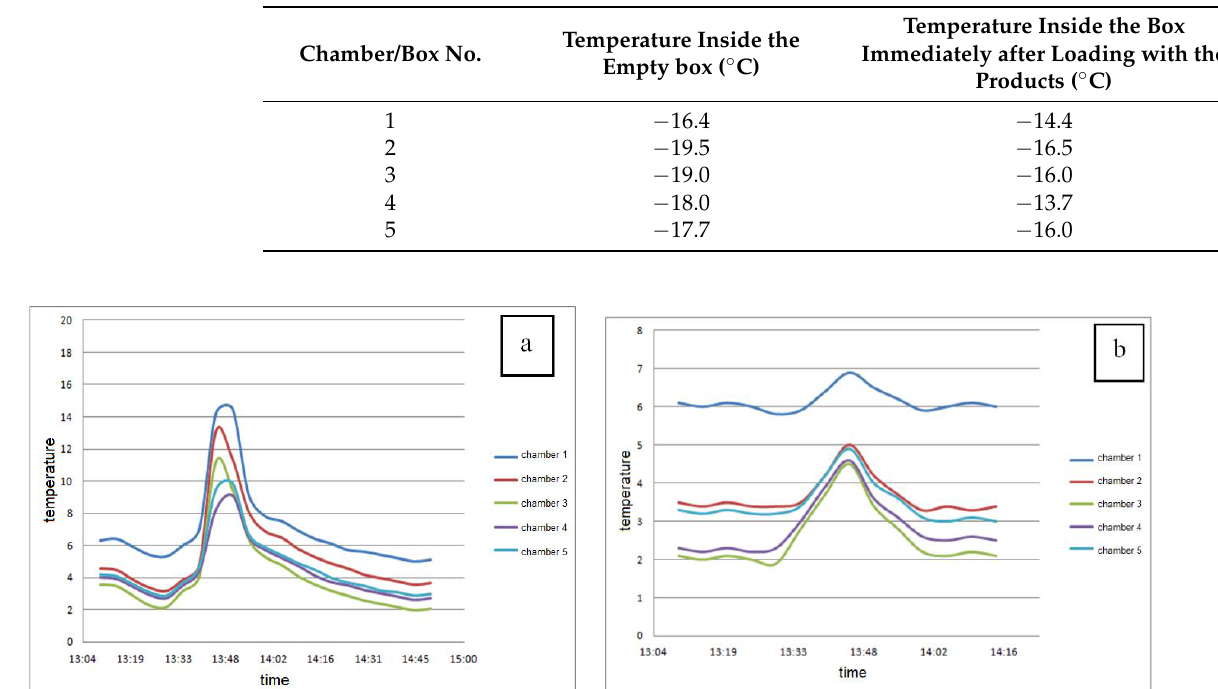
Figure 6. Temperature monitoring in the boxes of the cooling module during insertion of food products ( a ) or removal of food products ( b ) .